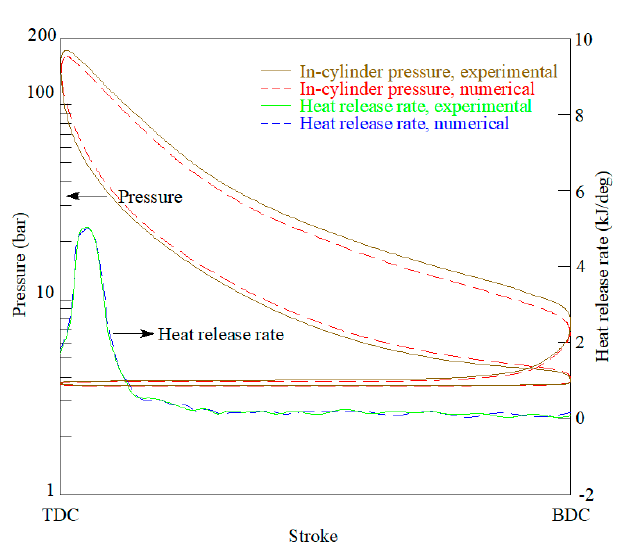
Figure 1. SFC and emissions.